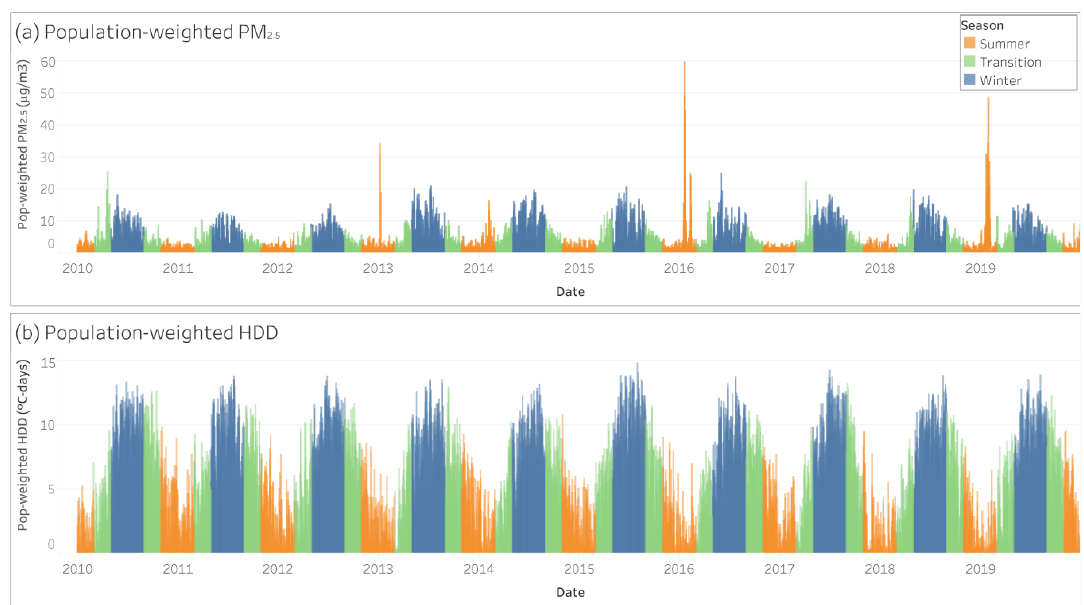
Figure 2. Average daily PM 2.5 concentration ( µ g / m 3 ) and HDD ( ◦ C-days) for the period of analysis by season. Table 2. Average number of days per year (total and %) and 24-h PM 2.5 summary statistics by day